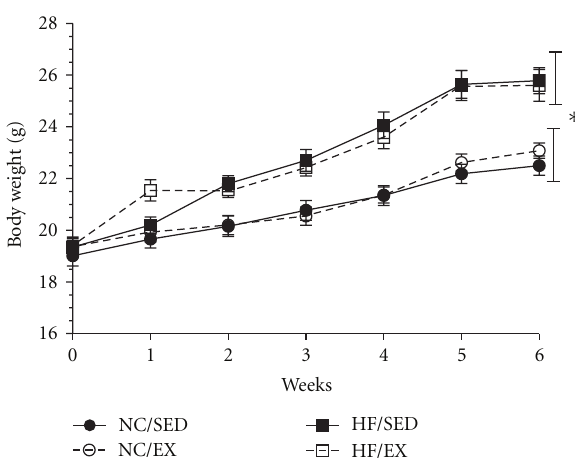
Figure 1: Weekly body weights over the course of 6wks while mice were exercise trained (EX) or sedentary (SED) and on either normal chow or high-fat diets (NC, HF). Closed circles : NC/SED; open Circles : NC/EX; closed Squares : HF/SED; open Squares : HF/EX. ∗ Diet e ff ect only ( P < 0 . 05). High-fat (45%) feeding resulted in overall greater body weights versus NC groups. Data are mean ± SEM. n = 10/grp.